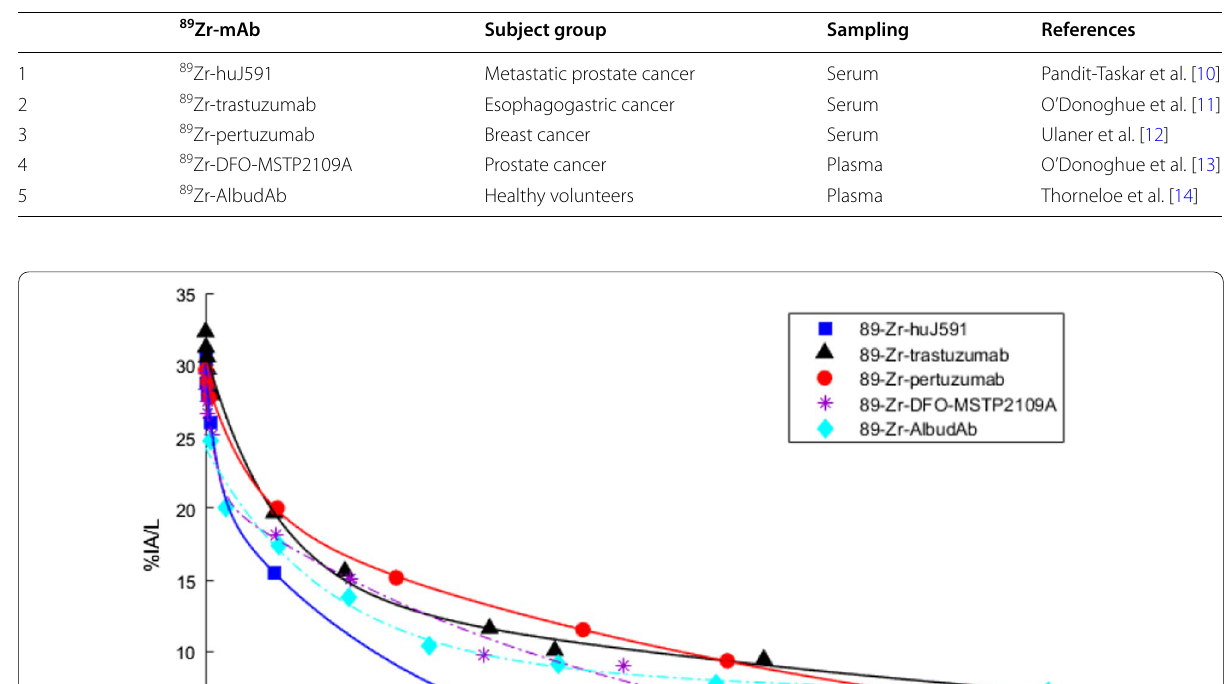
percentage injected activity per liter, h p.i. hours = =